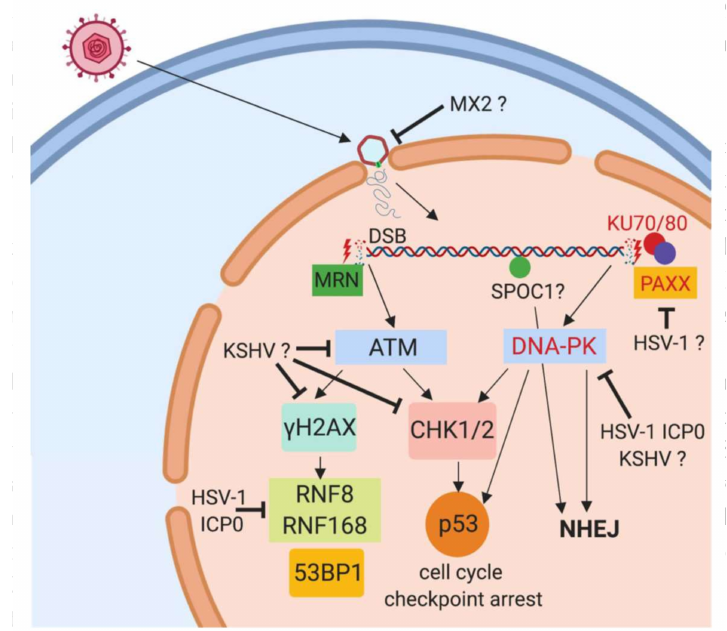
Figure 1. Herpesviral antagonism of the ATM- and DNA-PK-branch of the DDR directly after infection. After infection of target cells, the herpesviral capsid is transported to the nuclear membrane and the viral DNA released into the nucleus through nuclear pores. We propose that the cellular DDR complexes recognize the viral linear DNA by MRN- and KU70 / KU80-complex binding to double-strand break resembling ends of the linear viral DNA. This results in activation of kinases ATM and DNA-PK respectively, followed by phosphorylation of H2AX ( γ H2AX) and CHK1 / 2 and activation of downstream proteins including the cell cycle regulator p53. HSV-1, HCMV and KSHV have been shown to counteract this activation as indicated in the graph, however, the viral e ff ector proteins and mechanisms are not identified. Depletion of proteins depicted in red font has been shown to enhance herpesviral replication, indicating an inhibiting role on herpesviral replication. ? indicates an unknown